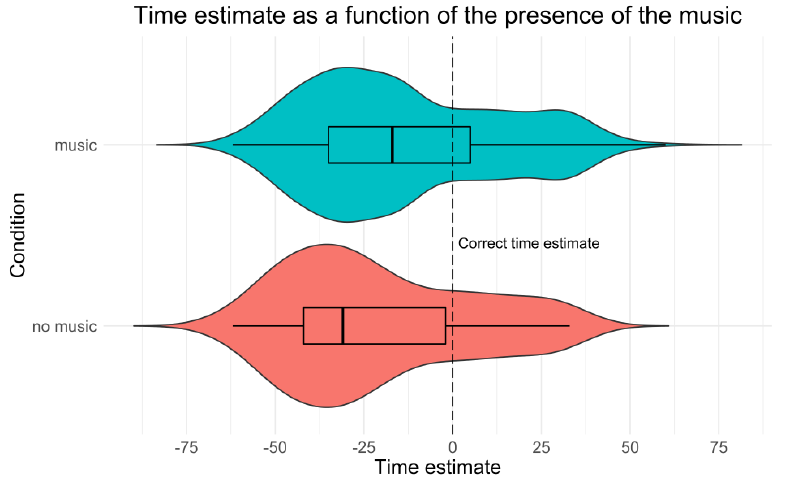
Figure 3. Time estimate (delta) as a function of the presence of the music (violin plot). The form of the violin indicates the distribution curve. The boxplots within each violin represent interquartile ranges (IQRs). Black vertical lines within the boxplots indicate median values. Values above zero represent overestimation; negative values indicate underestimation. Participants in the music conditions presented significantly higher time estimation.